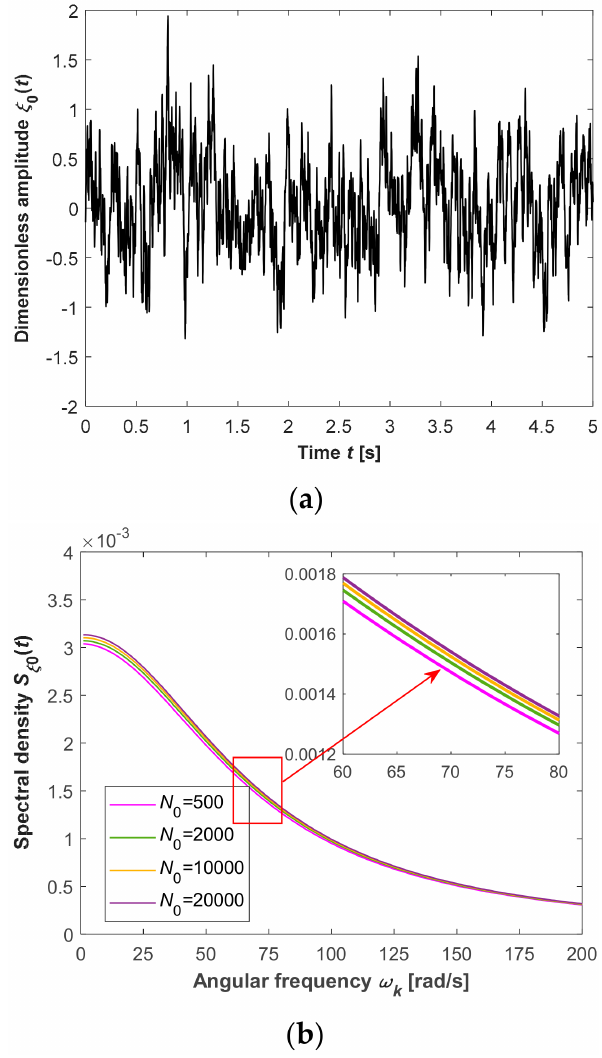
Figure 3. The bounded noise, where ( a ) is a sample function and ( b ) is its spectral